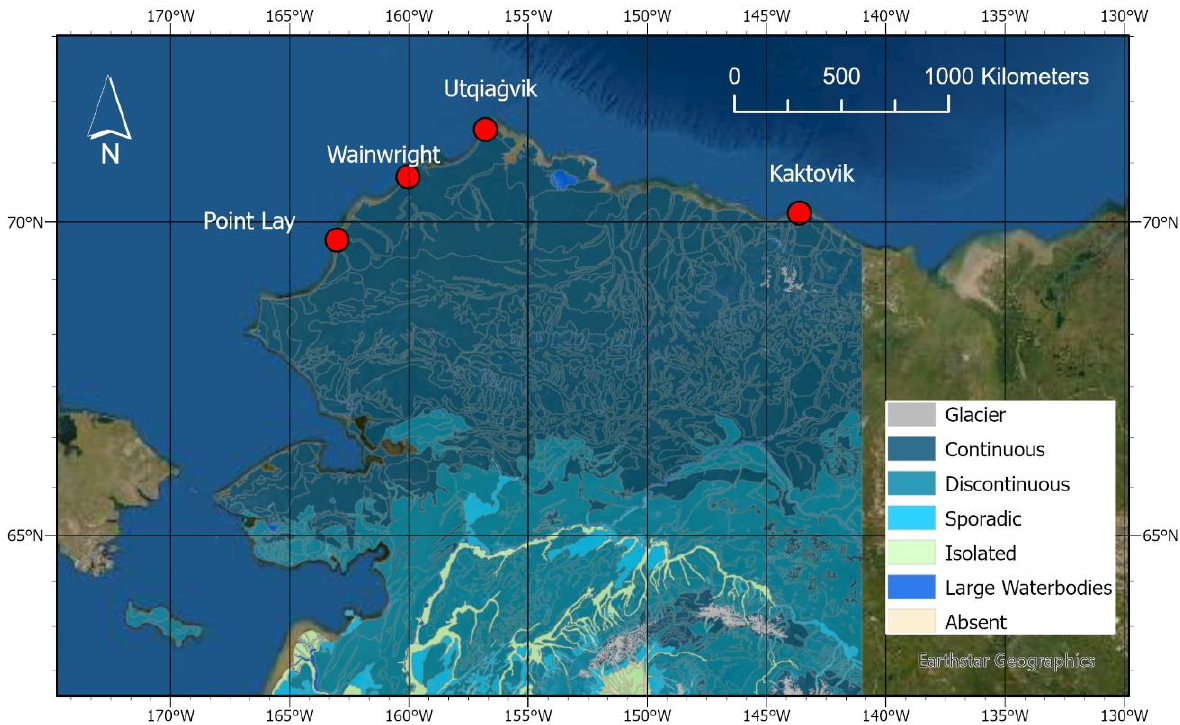
Figure 1. Permafrost distribution of Alaska. The map is adapted from the original developed by Jorgenson et al. [30]. The four collaborating communities are indicated with red markers.